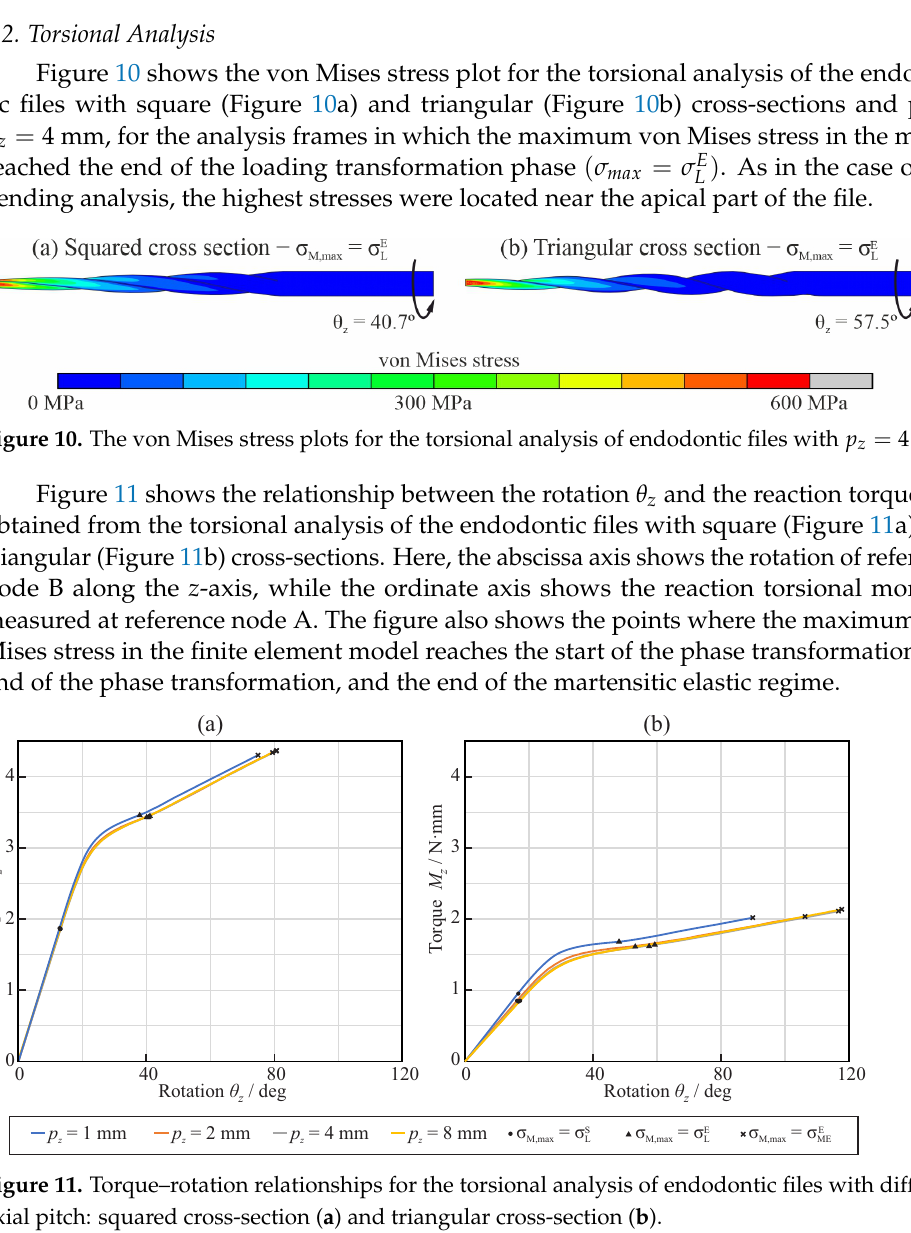
Figure 9. Bending analysis: effect of the pitch on the maximum principal strain ( a ) and the expected number of cycles ( b ) when the rotated angle is θ x = 20 ◦ .